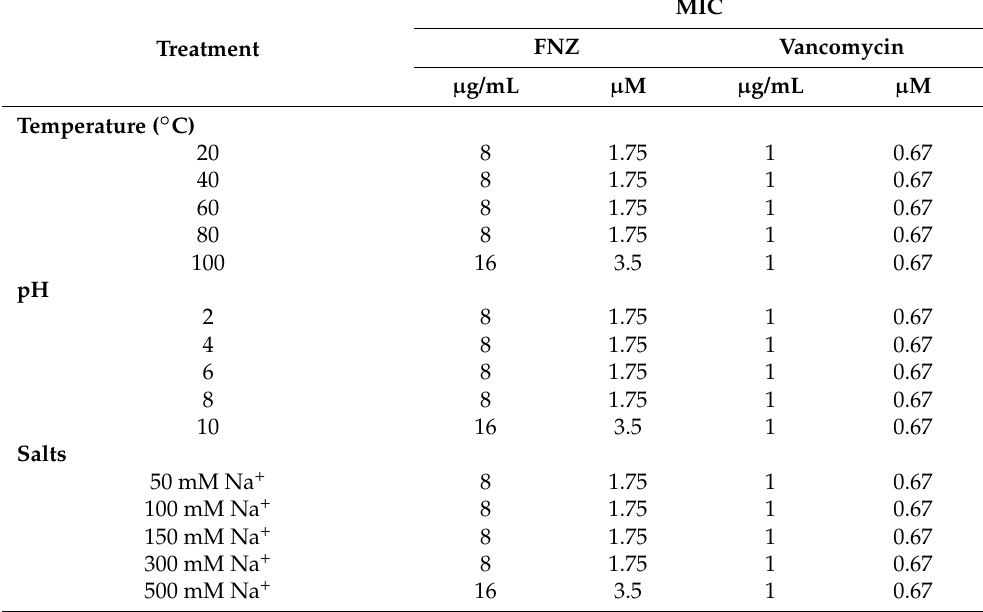
Table 3. Thermal, pH, salts, and protease stability of FNZ against S. aureus ATCC 43300.